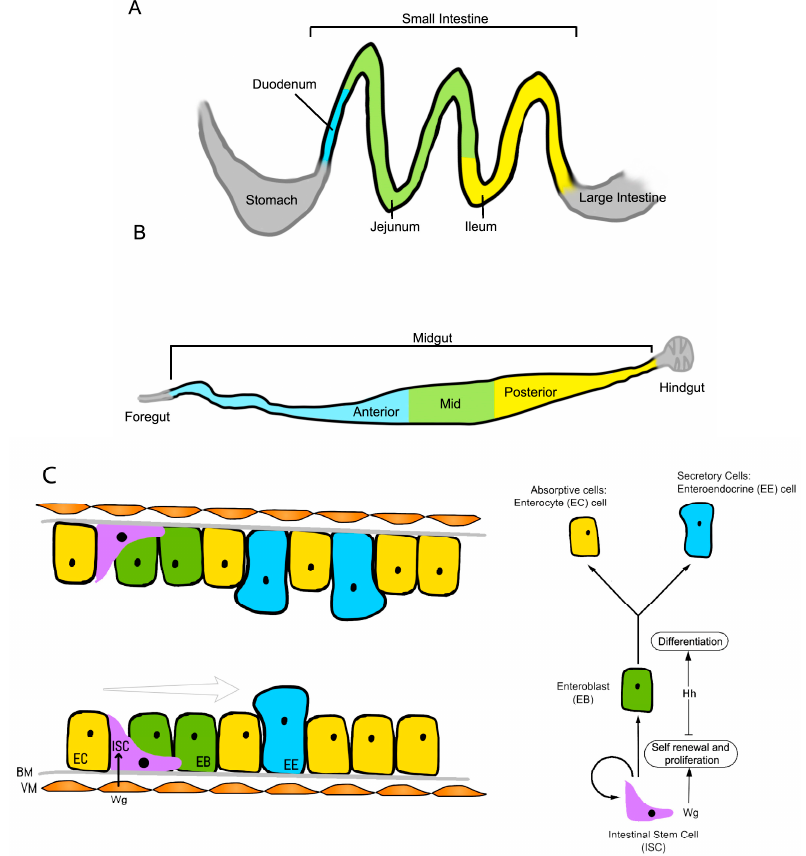
Figure 3. Schematic of the ( A ) mouse and ( B ) Drosophila intestinal systems; ( C ) Development of intestinal stem cells in the Drosophila hindgut. Wg/Wnt1 secretion from the visceral muscle (VM) promotes intestinal stem cell (ISC) proliferation and self-renewal. As the cells divide and move away from the Wg signal, exposure to hedgehog (Hh) induces the onset of enteroblast (EB) differentiation. Notch signaling determines the cell fate, with strong notch signals in the EBs favoring differentiation into enterocytes (ECs). BM: basement membrane; EE: Enteroendocrine.